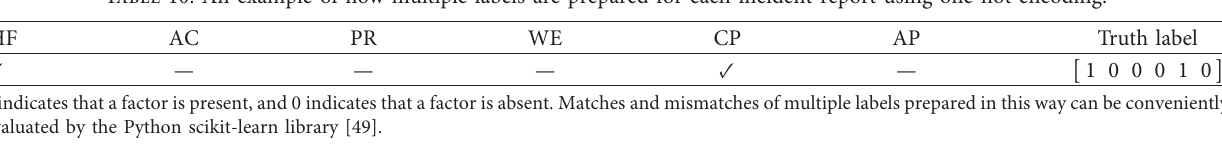
score is improved, especially for rarer factors, as 1